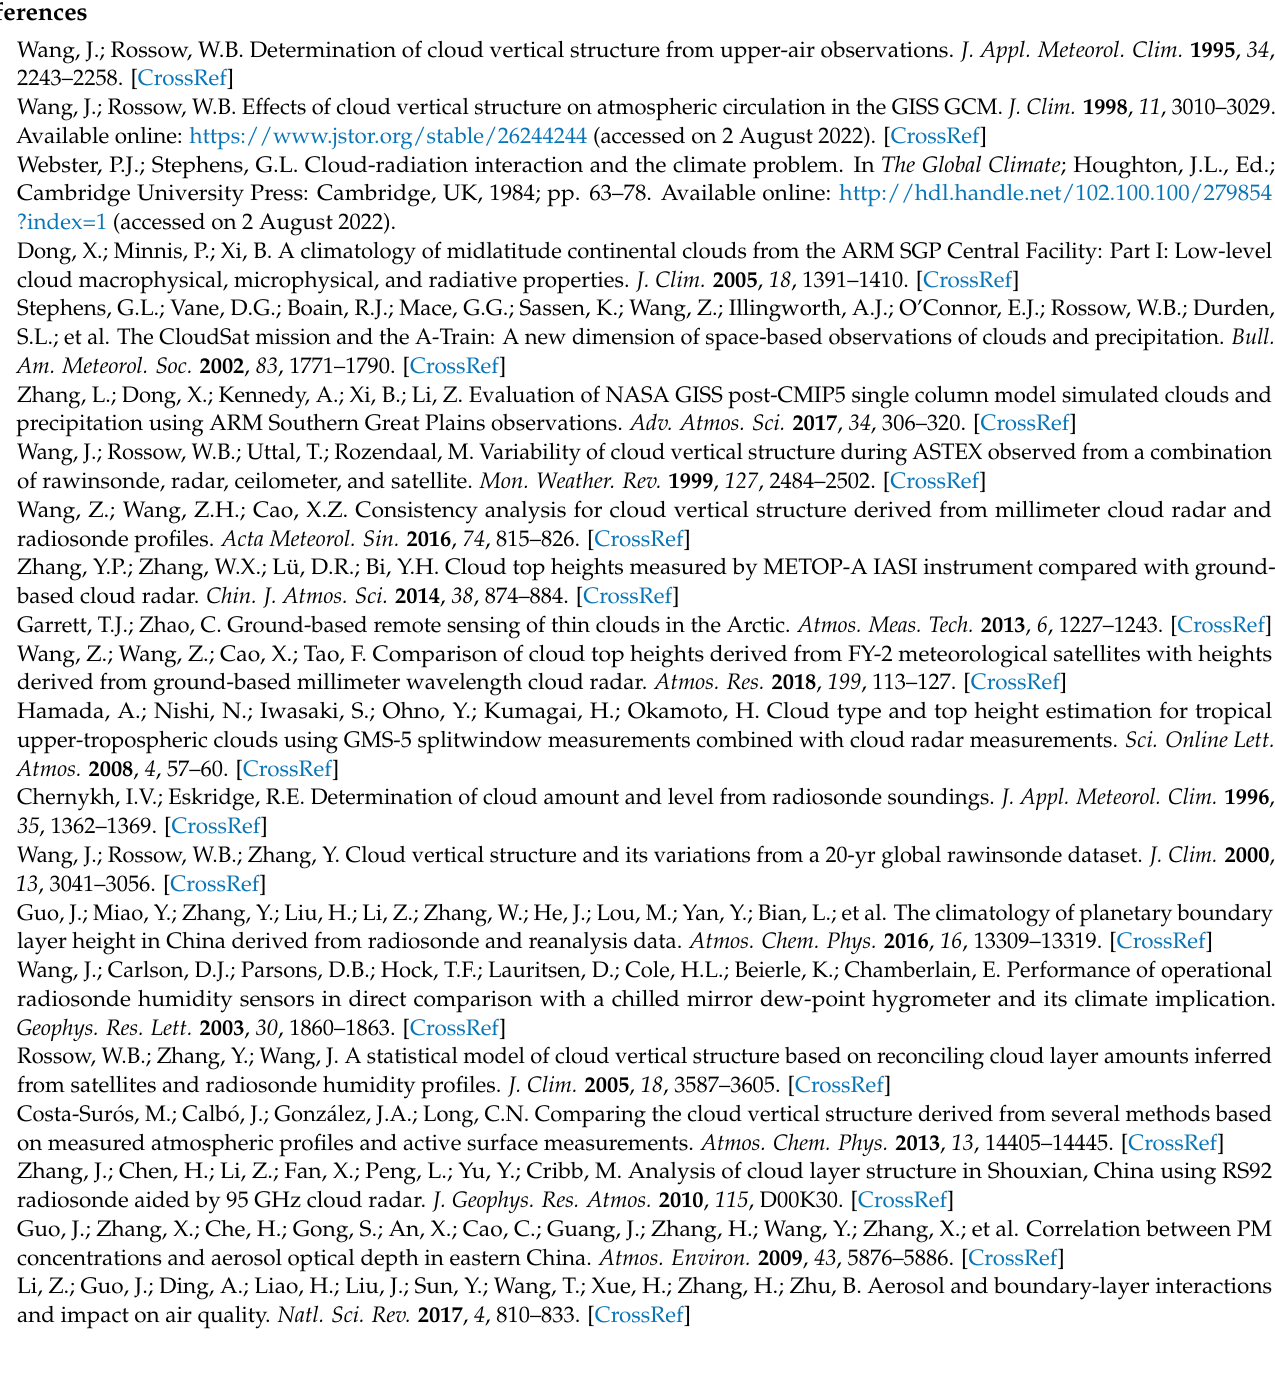
Figure A2 shows the same plots as Figure A1 but for 21 March 2021. The radiosonde overestimates the CTH, owing to the delayed response of its humidity sensor. The CTH detected by the radiosonde is 11.5 km. The average CTHs detected by the MMCR and the lidar are similar: 9.8 km and 9.9 km, respectively. Therefore, the CTH, in this case, is ~9.9 km. The height corresponding to the radiosonde temperature of − 50 ◦ C is 10.0 km, and the RH within the range of 10.0–11.5 km exceeds the RH threshold, and the wet layer is incorrectly identified as a cloud. Therefore, the cloud top is overestimated by 1.6 km by the radiosonde. Among the scenarios shown in Figures A1 and A2, 19% of cases (data from December 2020 to November 2021) are CTH overestimations due to the delay of the humidity